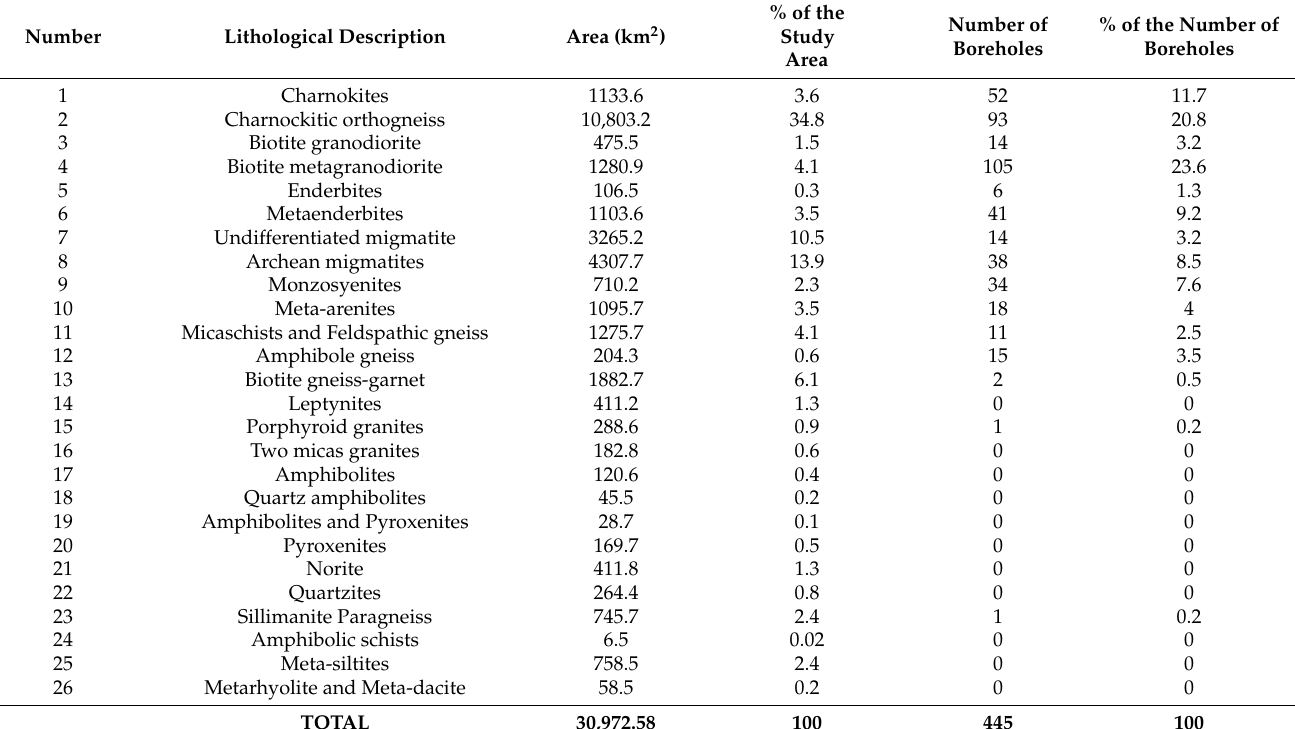
Table 4. Lithological units from the geological map and number of associated